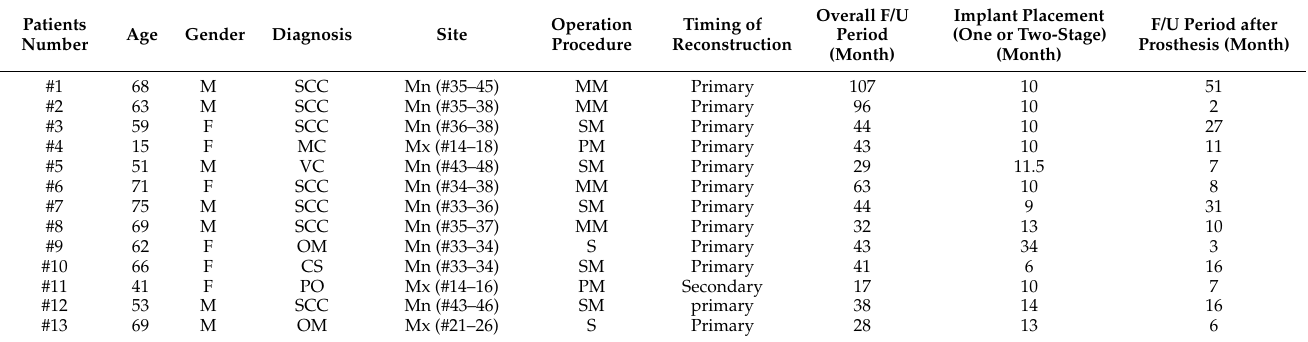
Table 1. Patients characteristics.